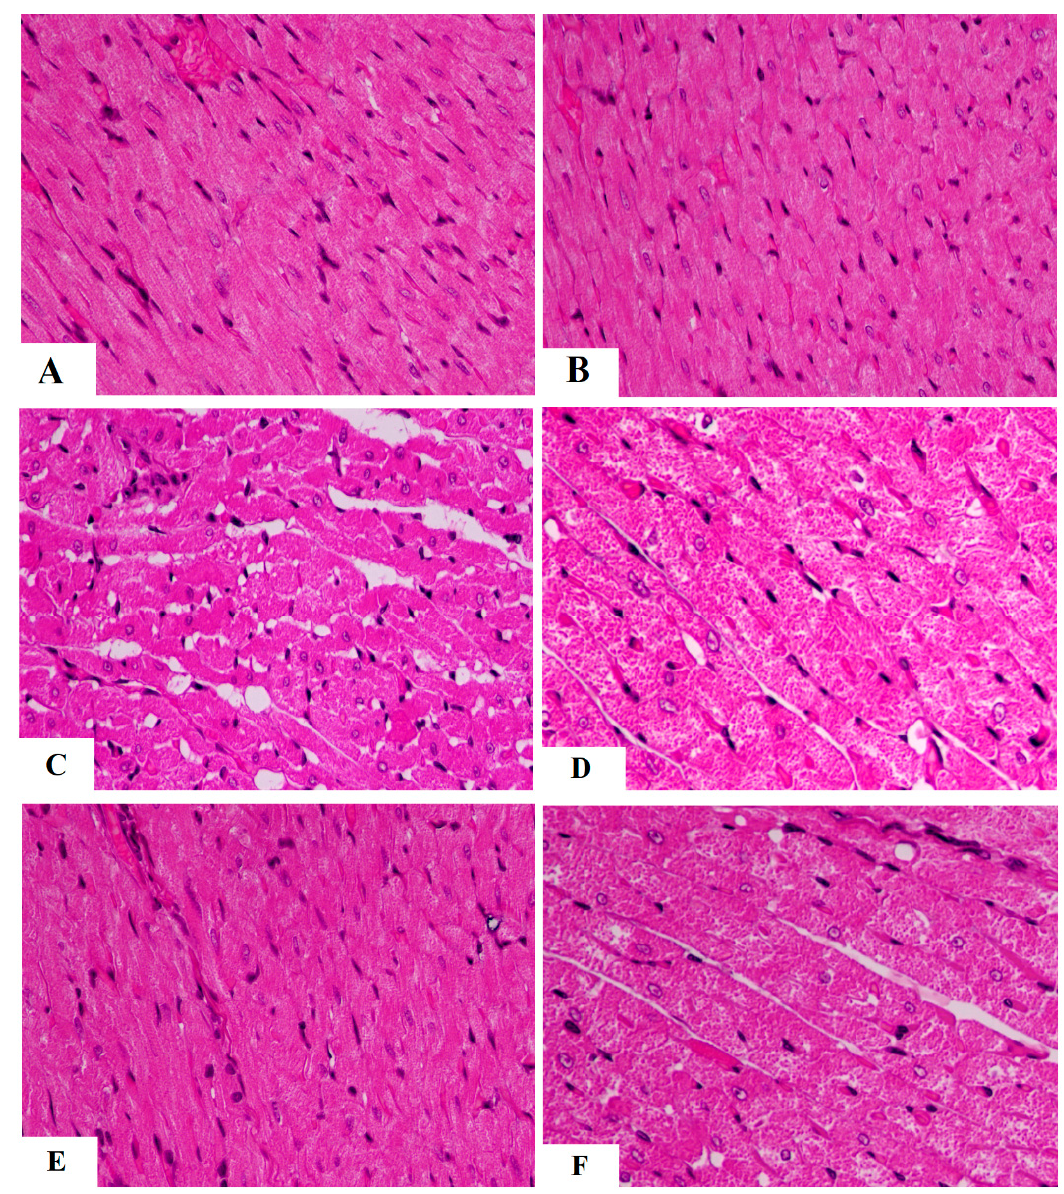
Figure 4. Morphological images of the left ventricles of all rat groups. ( A , B ) were taken from control